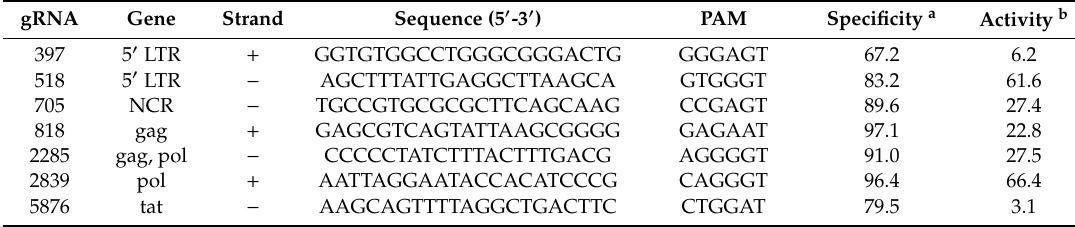
Table 1. Guide RNA (gRNA) sequence characteristics.